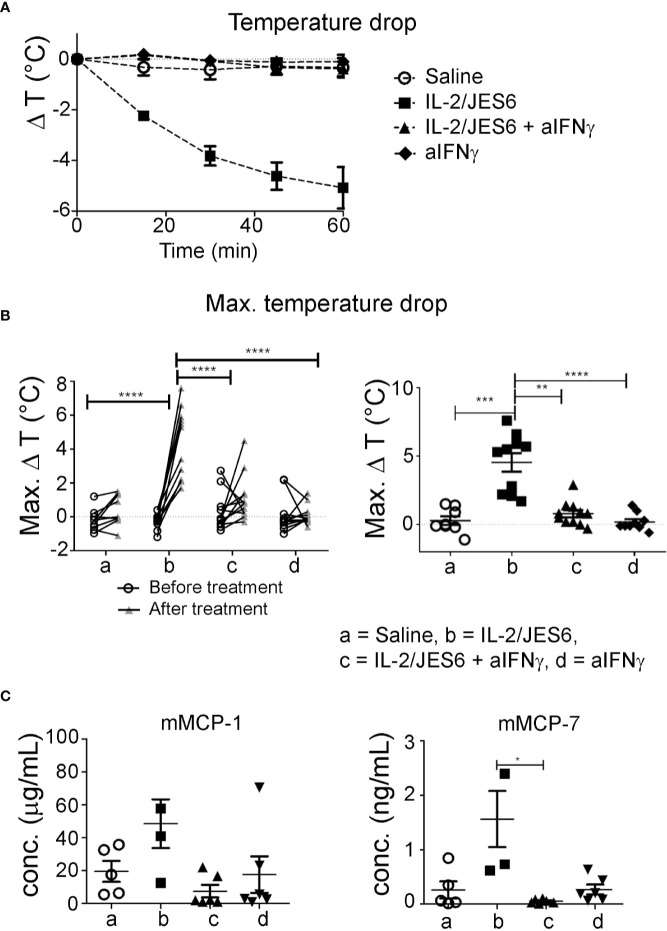
Impact of IFN-γ blockade. Egg-allergic mice were treated daily on three consecutive days with IL-2/JES6 and challenged with allergen after the last IL-2/JES6 injection. Some groups additionally received one or three injections of anti-IFN-γ blocking antibodies, with all or only the last injection of IL-2/JES6, respectively. Mice were challenged 4 h after the last IL-2/JES6 injection. (A) Temperature drop curve. Representative data from one of two experiments are shown (B) Changes of maximal temperature drops before and after anti-IFN-γ blockade in individual mice (left, statistics: two way ANOVA with Sidak’s multiple comparison test) and maximal temperature drops after treatment in the various groups (right, statistics: Kruskal-Wallis Test with Dunn’s multiple comparison test) are shown, as indicated. Data are pooled from two independent experiments. (C) Blood was drawn 1.5 h after the challenge and serum levels of mMCP-1 and mMCP-7 were measured by ELISA. Data represent mean ± SEM. Representative data from one of two experiments are shown (statistics: Kuskal-Wallis Test with Dunn’s multiple comparison test). *p < 0.05, **p < 0.005, ***p < 0.001, ****p < 0.0001.